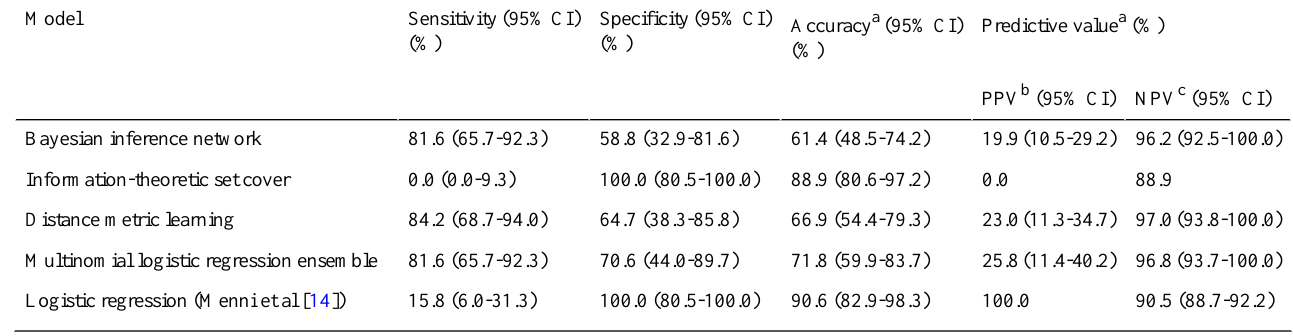
Table 3. Classification performance on the clinical test data set for the developed base and ensemble models compared to a logistic regression model reported in the literature.